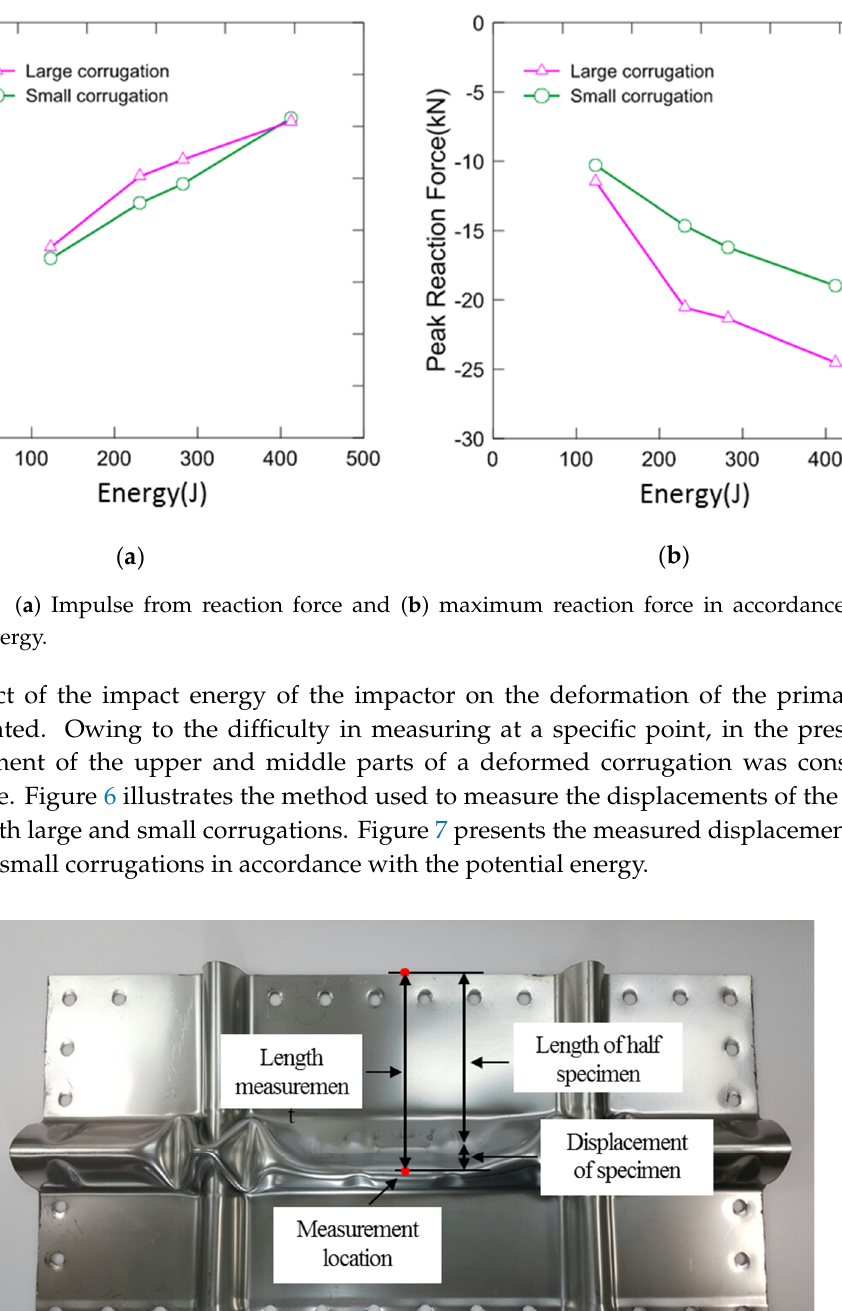
Figure 7. Comparison of displacement between large and small corrugation in accordance with impact energy. Analysis of the displacement at the first impact as in accordance with the impact energy shows that a small corrugation is more deformed than a large corrugation; this is understood in terms of the displacement of the upper and middle parts of the corrugation. Small corrugations have a less complex structure and smaller impact-affected area than the large corrugations that have four ribs to reinforce the buckling strength. Therefore, a specimen with a large corrugation exhibits more impact resistance under the same impact load. Moreover, the displacements of the small corrugation specimens linearly increase over the entire impact energy, but the displacement of the specimens from L123 to L282, except L412, linearly increase. Under the impacts, small corrugations exhibit the characteristics of a localized plastic deformation only for the impacted area rather than